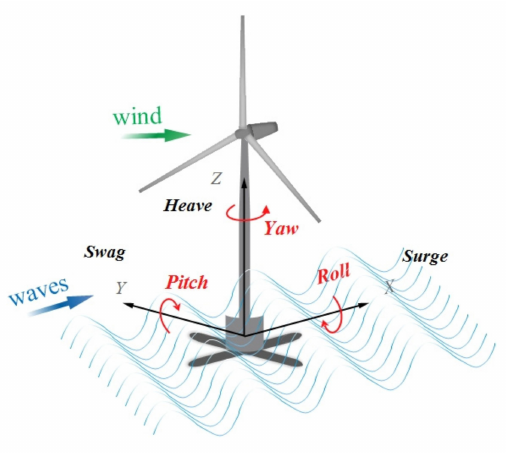
Figure 1. Motion types of the floating offshore wind turbine